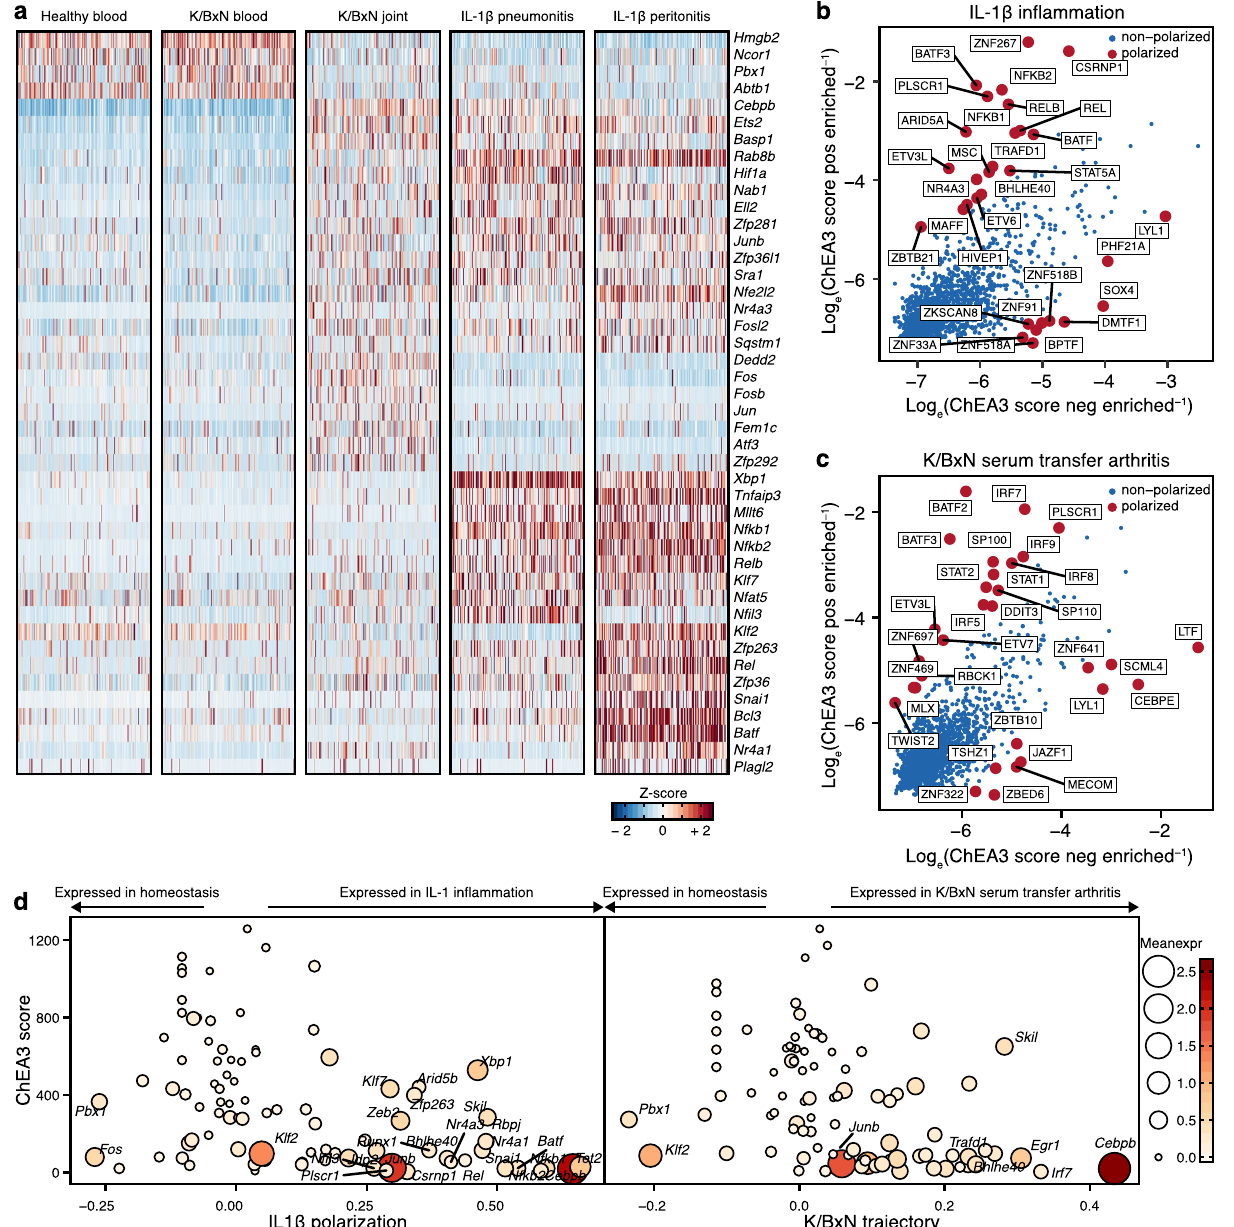
Fig. 8 Transcriptional regulation of acute and subacute in fl ammation. a Overview of differentially expressed transcription factors in healthy blood and in fl amed compartments. As in Fig. 1c, marker genes for each condition were identi fi ed by Wilcoxon Rank Sum test (two-tailed) using the Seurat function “ FindAllMarkers ” with standard settings; only genes with log ≥ 0.25 and Bonferroni adjusted p value ≤ 0.05 were e fold change between conditions considered. The list of marker genes was subsetted to transcription factors to display differentially expressed transcription factors between conditions. Cells were randomly downsampled to 200 cells per condition for plotting only. b , c Inferred regulatory activity of TFs in IL-1 β -induced and K/BxN-induced in fl ammation. As ChEA3 contains libraries from multiple species, only the corresponding human protein symbols are shown. d Inferred activity versus actual expression of TFs in IL-1 β polarization and along the K/BxN trajectory in the diffusion